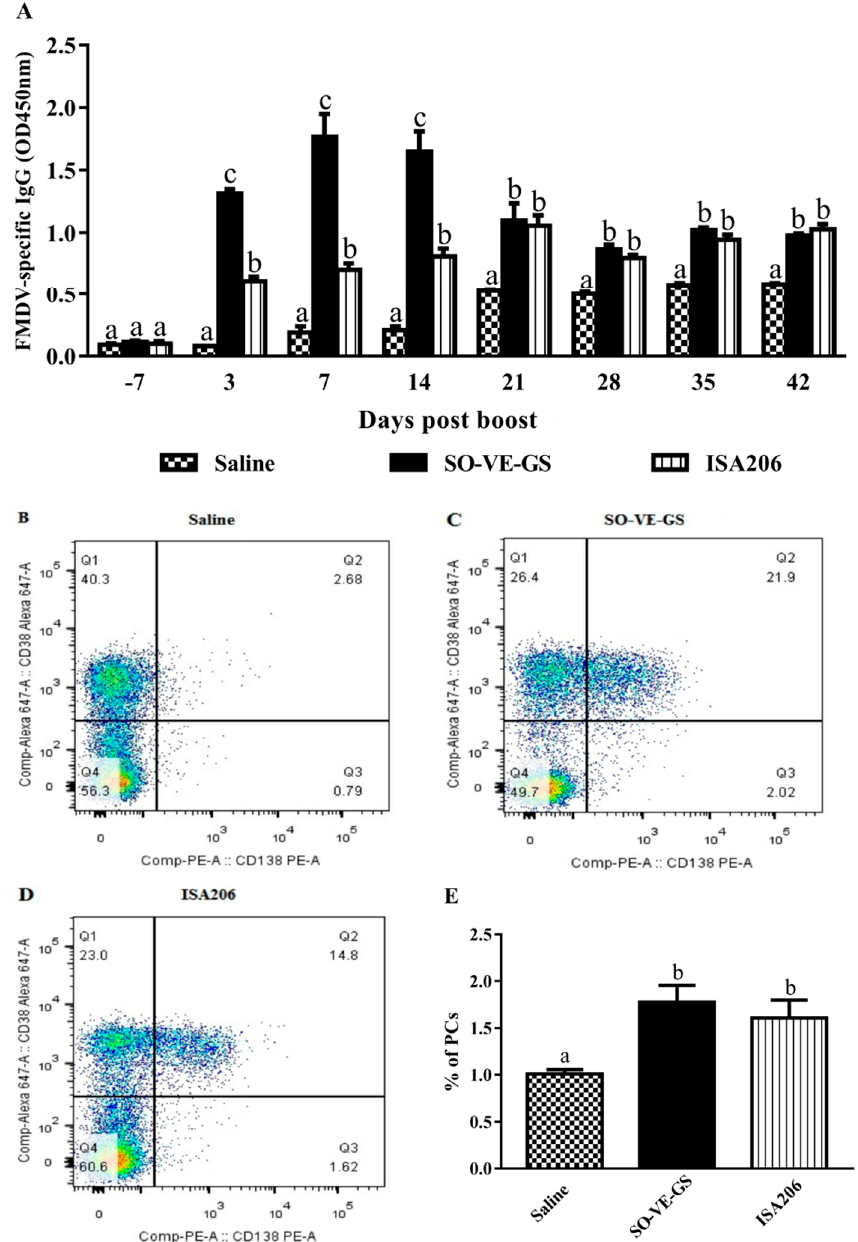
Figure 2. Timing and duration of serum FMDV-specific IgG responses and percentages of BMPCs in mice. Mice ( n = 6 / group) were i.m. immunized twice at a 2-week interval with the FMDV antigen in saline solution or adjuvanted with SO-VE-GS or ISA 206. ( A ) Blood samples were collected 7 days before and 3, 7, 14, 21, 28, 35, and 42 days after the boost to measure FMDV-specific IgG. ( B – D ) Bone marrow cells ( B , C ) were collected 42 days after the boost, and plasma cells (PCs) were identified as CD138 + CD38 - cells by flow cytometry. ( E ) The percentages of PCs. The values are presented as means ± SE. Bars with different letters are statistically different ( P < 0.05).